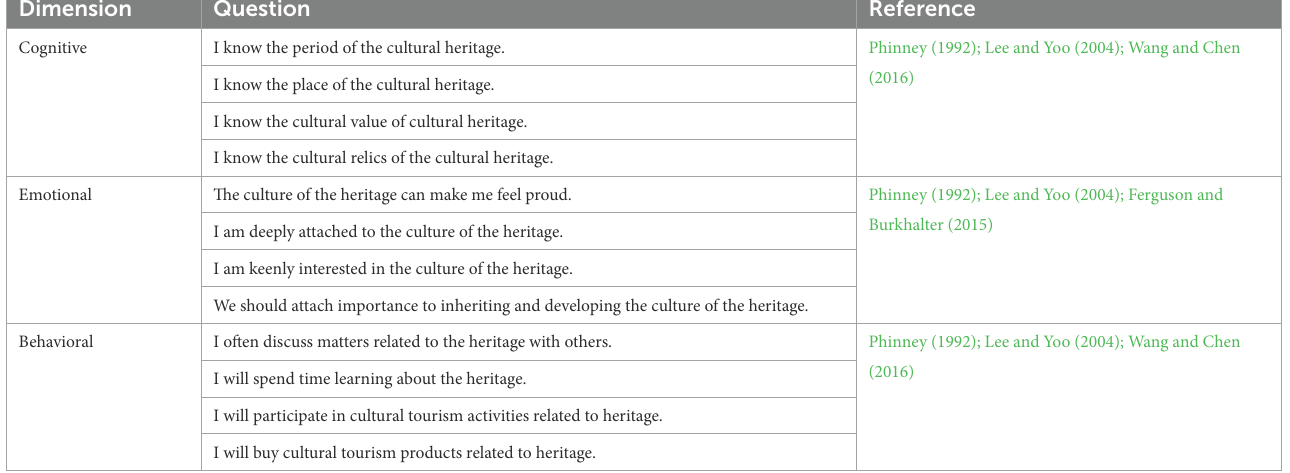
TABLE 1 The cultural identity scale used in the present study. Dimension